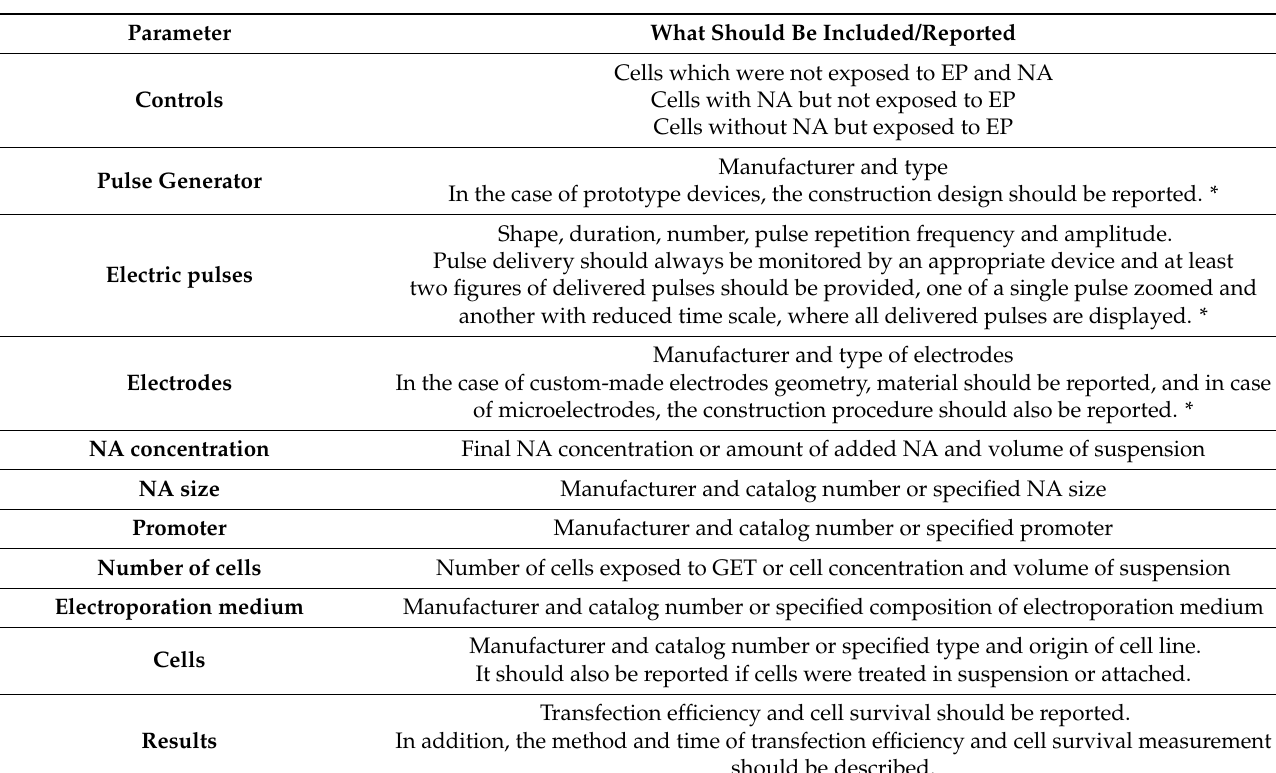
Table 4. Recommendations for reporting of parameters of in vitro GET